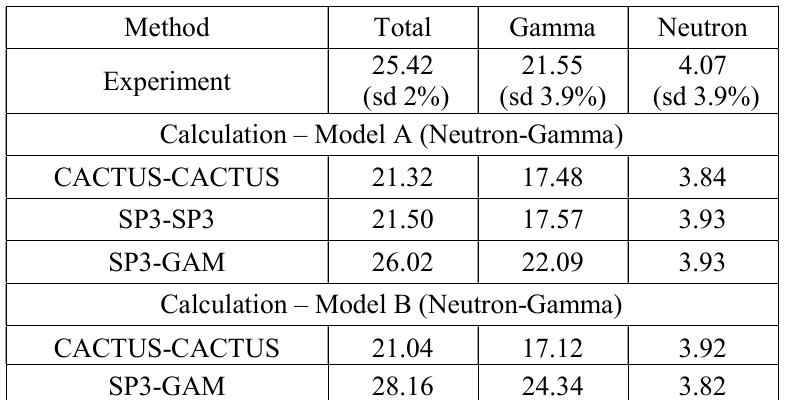
Table IV. Heating (micro W/g) : Graphite Detector